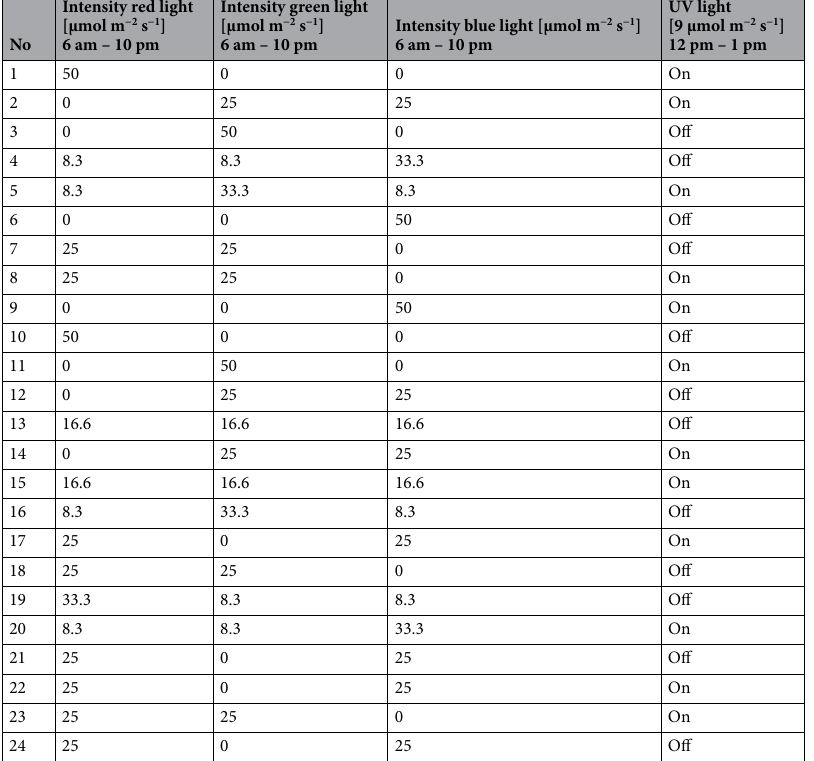
Table 1. Light compositions to determine the effect of light on the anthocyanin content of grapevine cultures. Generated using Design-Expert